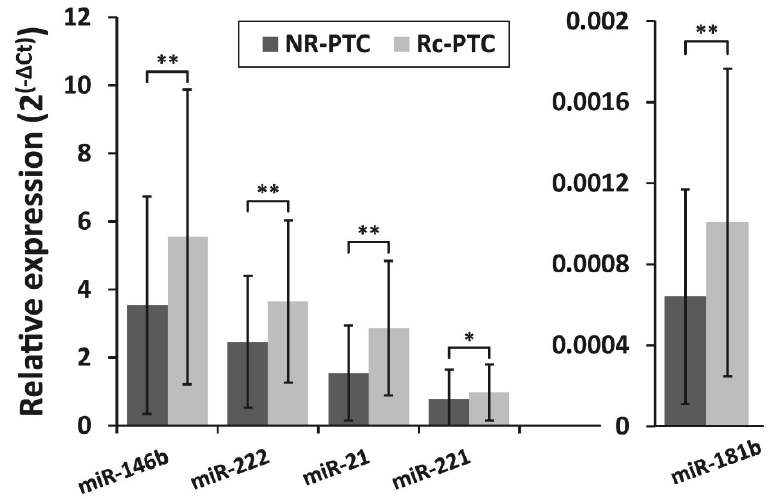
Figure 1. The relative expression levels of miR-146b, miR-222, miR-21, miR-221, and miR-181b in two patient groups—with recurrent papillary thyroid carcinoma (PTC) (Rc-PTC, n = 87) and without the